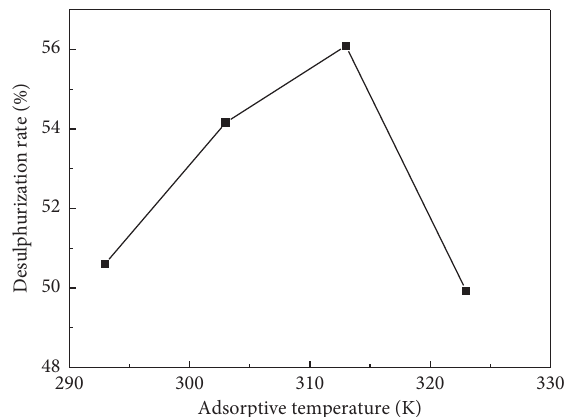
Figure 7: Effects of adsorption temperatures onto Mn/AC (model oil DM0, 20mL; DBT, 9.38mmol · L − 1 ; adsorbents, 0.2g 2wt. % Mn/ AC; adsorption time, 4h).